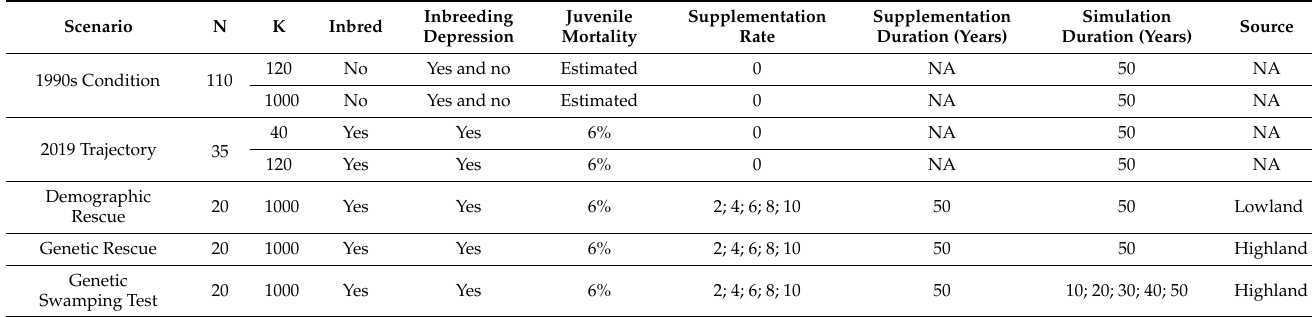
Table 1. Scenarios simulated in Vortex. Initial lowland population size ( N ), carrying capacity ( K ), whether or not the starting population was made inbred by providing a kinship matrix (Inbred), whether inbreeding depression was modelled, and whether estimated or adjusted values for juvenile (0–1 y) mortality were used is indicated. Supplementation rate is the number of individuals supplemented (by translocation) into the population per year. Supplementation duration is the number of years the population was supplemented. Simulation duration is the number of years simulations were run. Source is the population that animals were sourced from for supplementation.